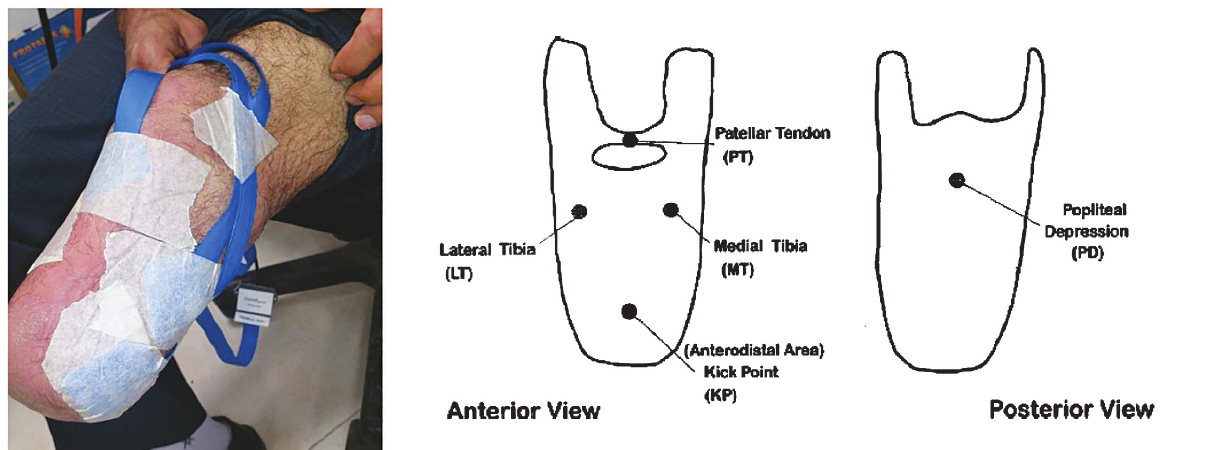
Figure 1. Places that pressure sensors are attached to the stump. a: common anatomical landmarks for weight bearing regions. Adapted from 12 , b: example of sensor placement on the participant’s